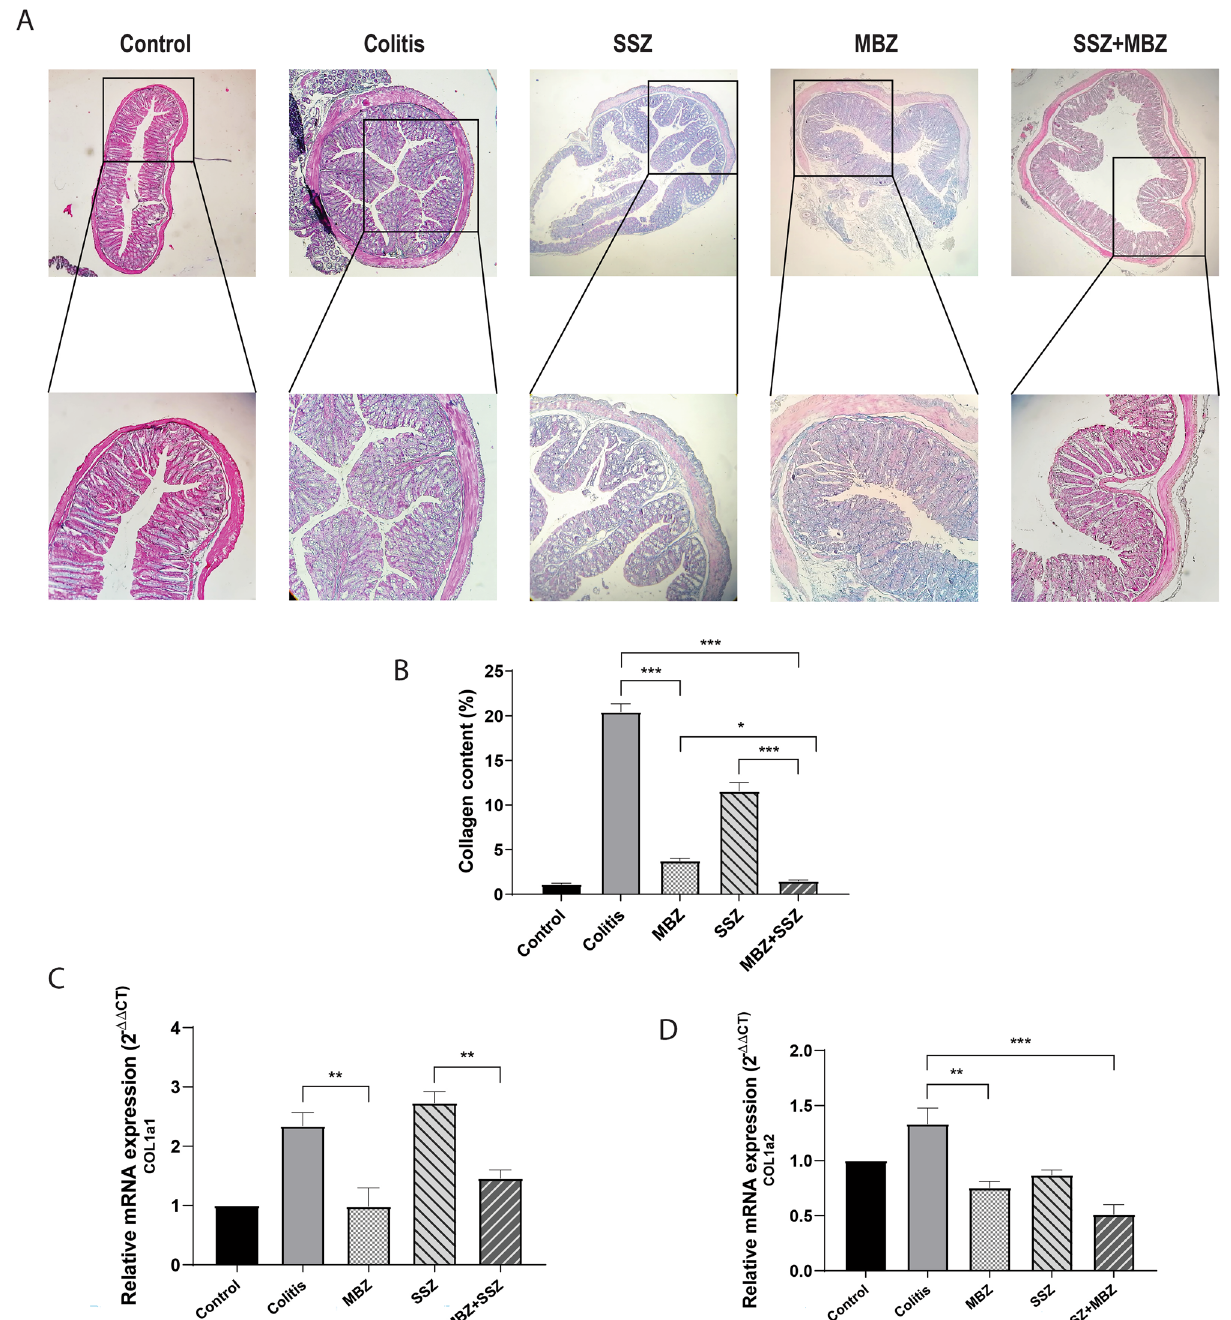
Figure 5. Mebendazole attenuates fibrosis and reduced collagen content. ( A ) Collagen fiber was detected using Masson’s trichrome staining. Mebendazole alone or in combination with sulfasalazine significantly reduced collagen deposition. ( B ) Amount of collagen deposition is quantified using Image J software. ( C – D ) qRT-PCR results showed the potential effect of MBZ on reducing pro-fibrotic genes including Col1a1 and Col1a2. * P < 0.05, ** P < 0.01, *** P < 0.001. Data were presented as Mean ± SEM, One-way ANOVA followed by post-hoc LSD test. Data are representative of three independent experiments with 6 mice in each group (n =